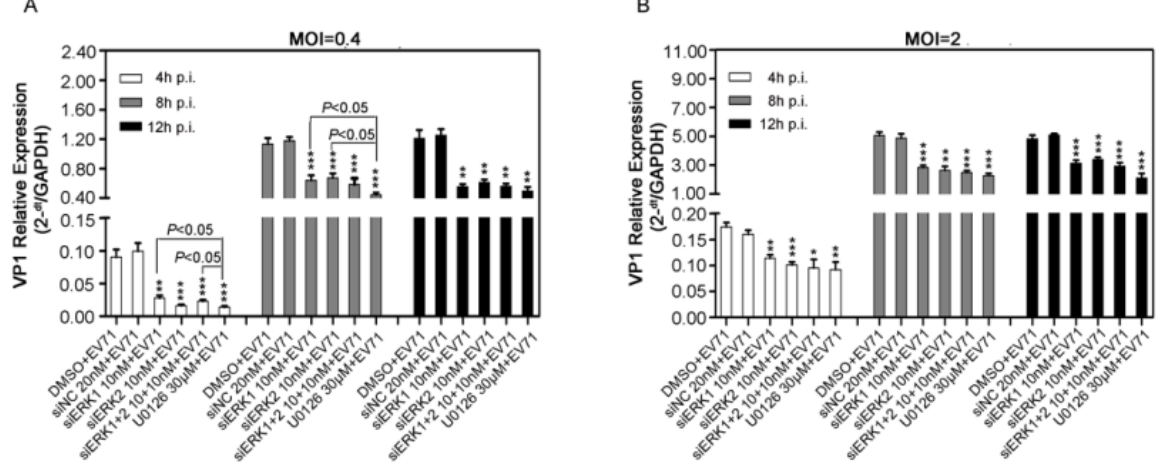
Figure 3. Effects of ERK1 and ERK2 on viral RNA synthesis in RD cells. RD cells pre-treated with siERK(s) or U0126 were infected with EV71 at the MOI of 0.4 (panel A ) or 2 (panel B ). Then at the indicated time points p.i., both supernatants and cell lysates were collected, viral VP1 gene among total viral genomes was quantified by relative qPCR. Data were the means of three independent experiments and error bars were denoted the